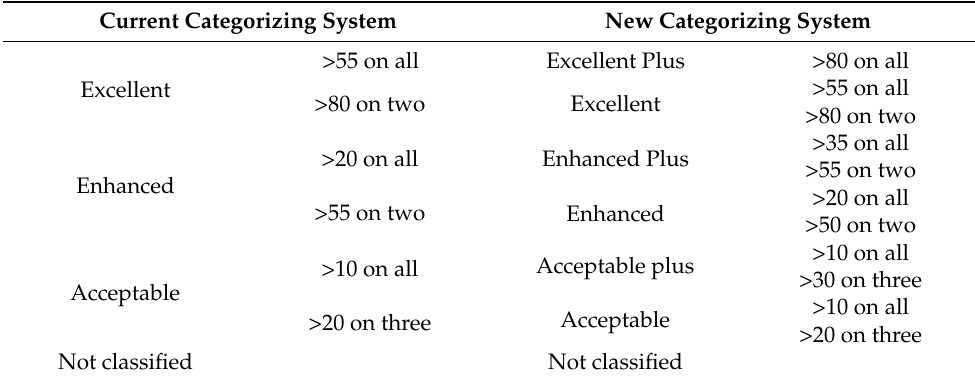
Table 3. Minimal principle scores were necessary to achieve the welfare